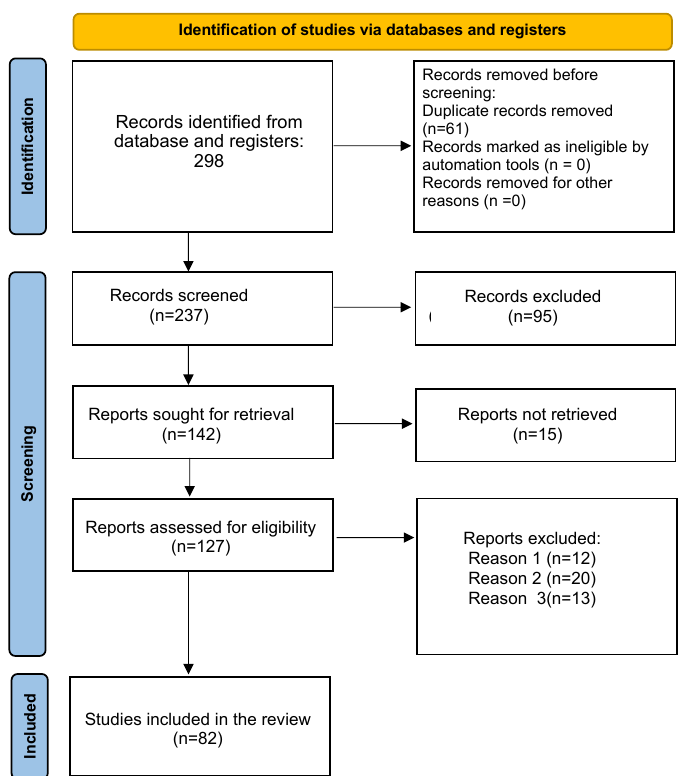
Figure 1. Preferred Reporting Items for Systematic Reviews and Meta-Analysis (PRISMA) on COVID- 19 and psoriasis. From: Page MJ, McKenzie JE, Bossuyt PM, Boutron I, Hoffmann TC, Mulrow CD, et al. The PRISMA 2020 statement: an updated guideline for reporting systematic reviews. BMJ 2021, 372, n71. doi: 10.1136/bmj.n71 For more information, visit: